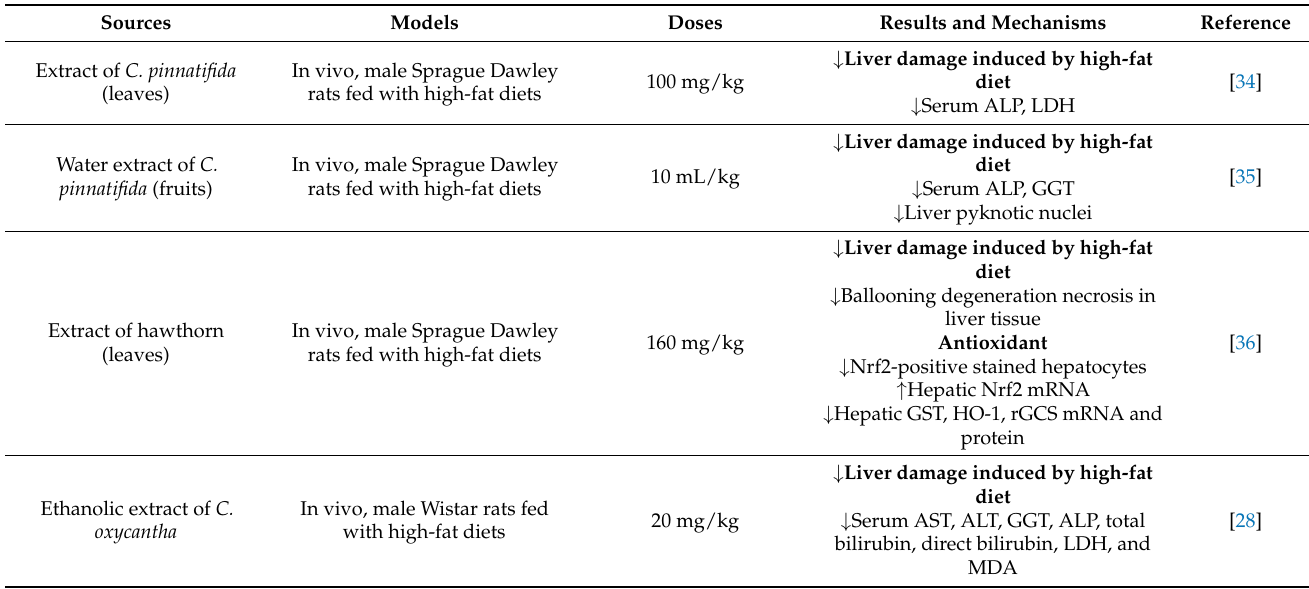
Figure 1. Hepatoprotective roles of hawthorn extract against liver damage induced by diet, al- cohol, toxicant, heavy metals, and partial hepatectomy. ARE, antioxidant response element; Bax, Bcl-2-associated X protein; Bcl-2, B-cell lymphoma-2; DPPH, 2,2-diphenyl-1-picrylhydrazyl; GSH-Px, glutathione peroxidase; GST, glutathione S-transferase; HO-1, heme oxygenase-1; LDL, low-density lipoprotein; MPO, myeloperoxidase; Nrf-2, nuclear factor erythroid-2-related factor 2; PARP, poly- ADP ribose polymerase; P. Carbonyl, protein carbonyl; rGCS, r-glutamylcysteine synthethase; SOD, superoxide dismutase; TBARS, thiobarbituric acid reactive substances; and TUNEL, terminal de- oxynucleotidyl transferase dUTP nick end labelling. Table 1. Hepatoprotective effects and molecular mechanisms of hawthorn